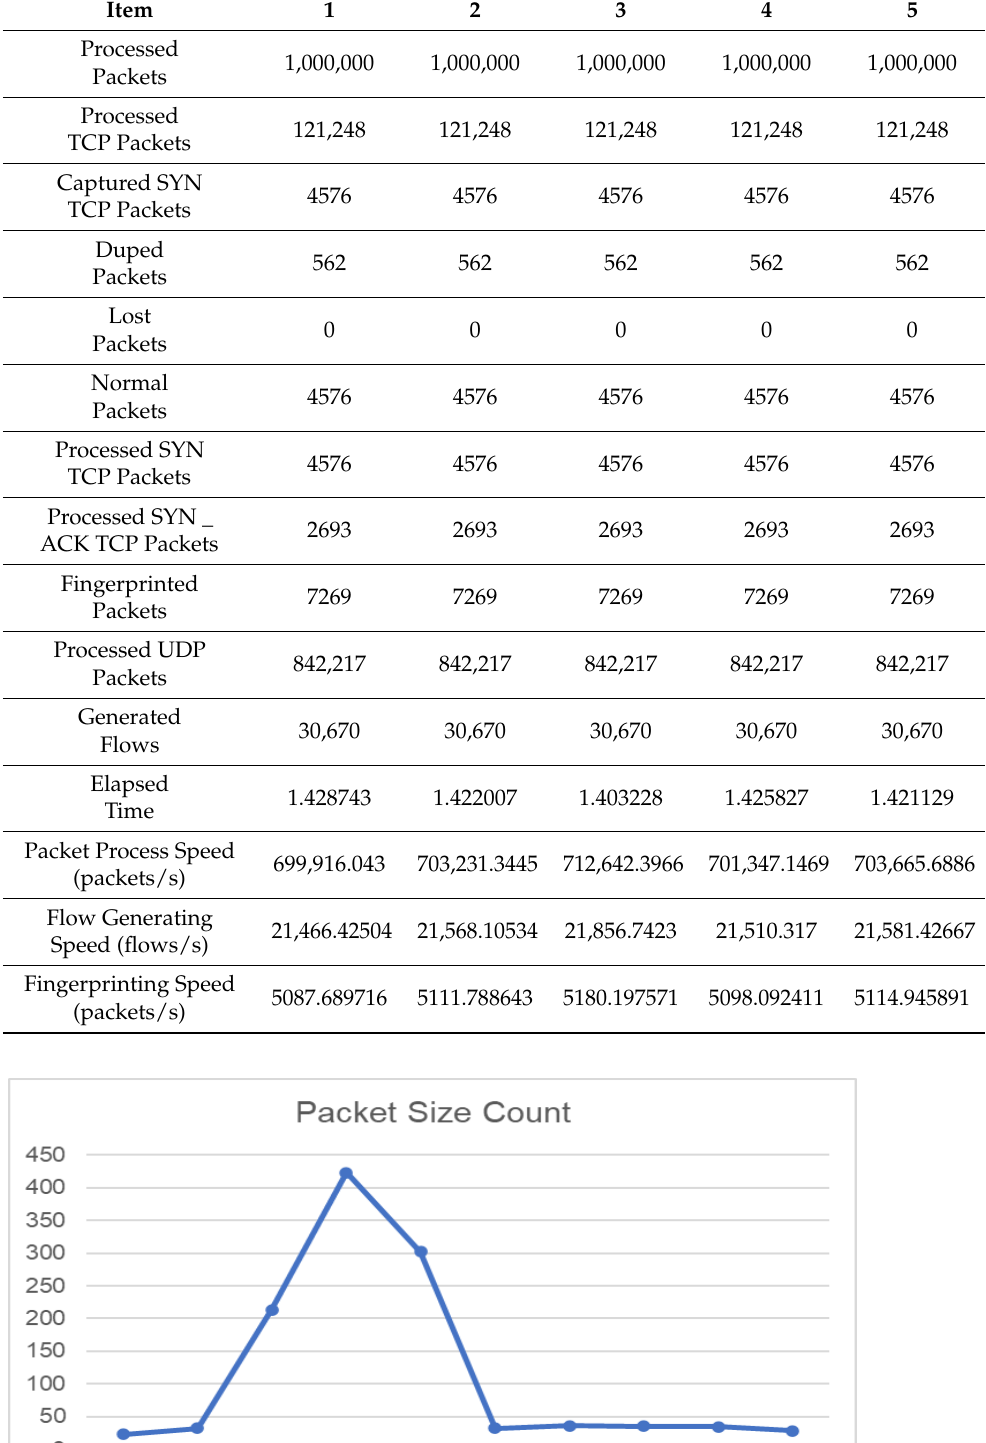
Table 12. Test results for the metadata storage speed.